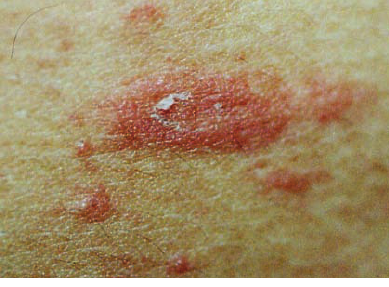
Figure 3. Typical herald patch in pityriasis rosea, showing collarette scaling configu- ration.